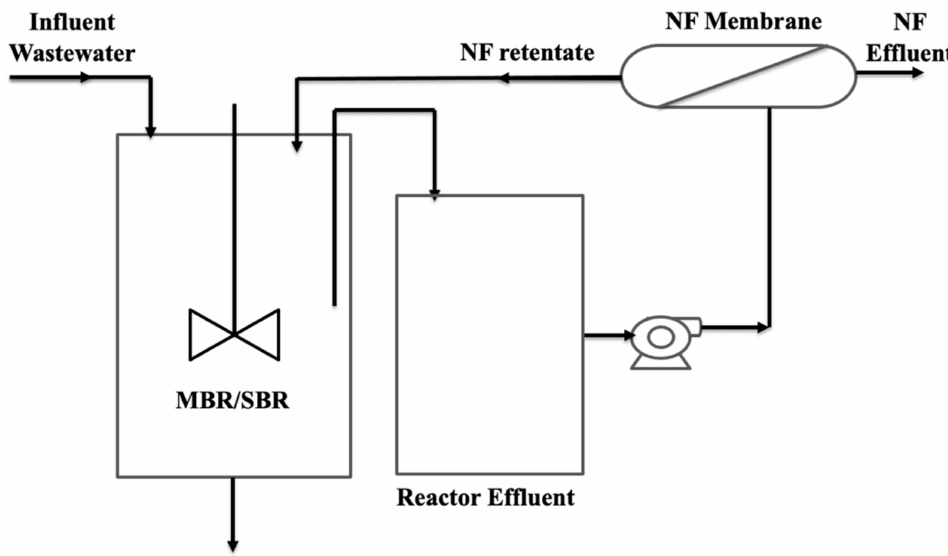
Figure 4. Nanofiltration-coupled membrane bioreactors (aerobic and anaerobic)